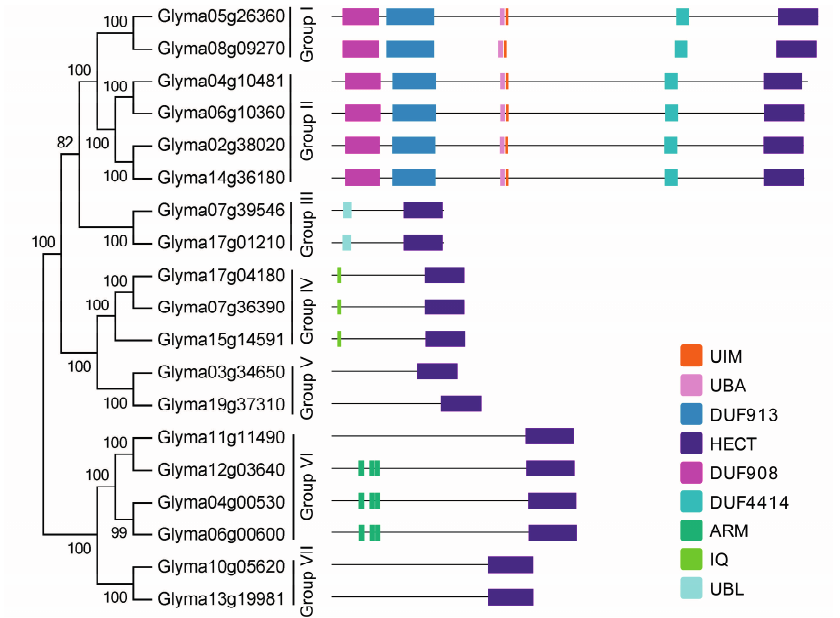
Figure 4. Domain architectures of soybean HECT proteins according to phylogenetic relationships. Each domain is represented by a colored box. UIM: Ubiquitin-interacting motif; UBA: Ubiquitin associated domain; DUF: Domain of unknown function; ARM: Armadillo repeats; IQ: IQ short calmodulin-binding motif; UBL: Ubiquitin like